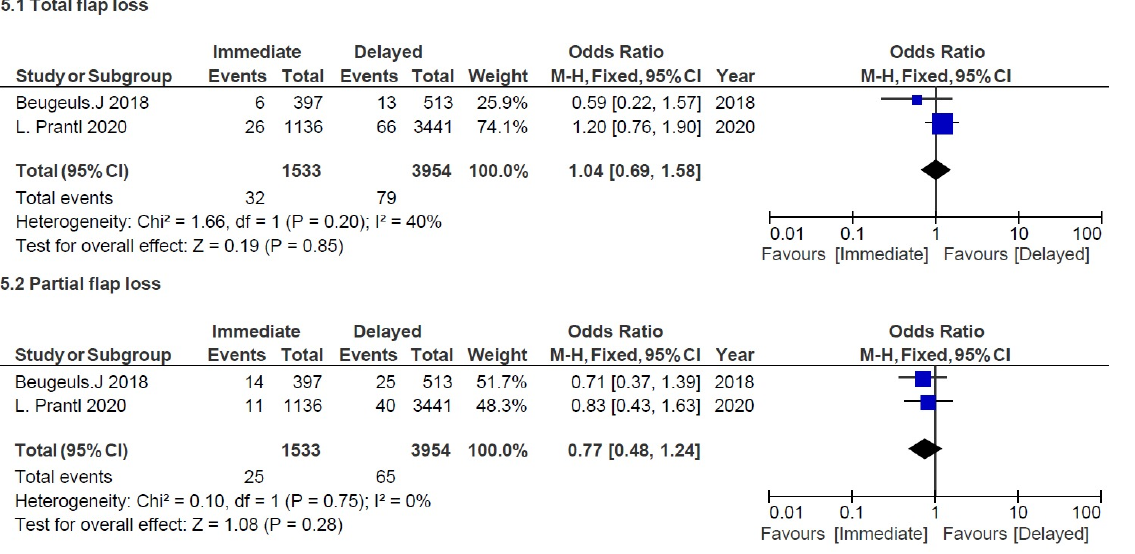
Figure 4. Combined ORs to assess effect of immediate versus delayed DIEP on adverse events for major complications: ( 5.1 ) total flop loss, and ( 5.2 ) partial flap loss [8,9]. Blue shapes correspond to individual studies. Squares size is proportional to the weight of the study while black diamonds shapes correspond to pooled studies.